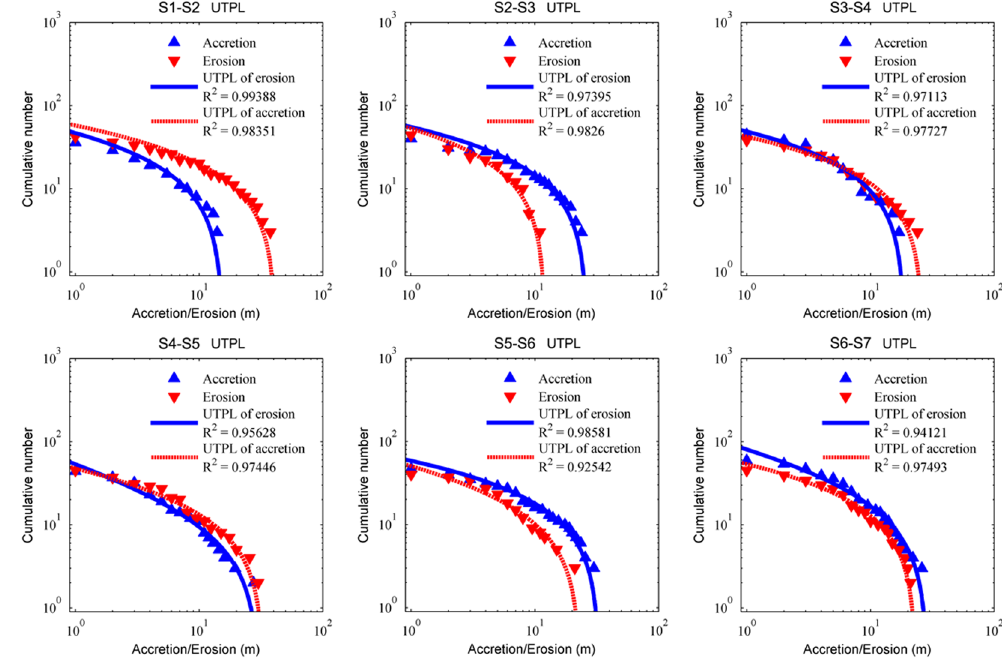
Figure 5. The cumulative distributions of the amounts of shoreline accretion and erosion during the surveys. The plotted points are statistical data based on surveys, which were fit with upper-truncated power law (curved lines); R 2 is the square of correlation coefficient for the data points and upper-truncated power law.